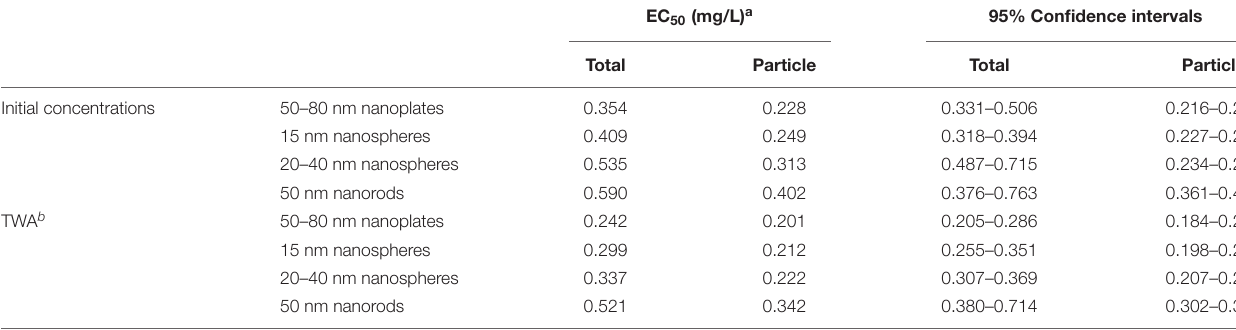
TABLE 2 | The EC 50 values of AgNPs (total) and AgNPs (particle) expressed on initial concentrations and expressed on time weighted average concentrations.